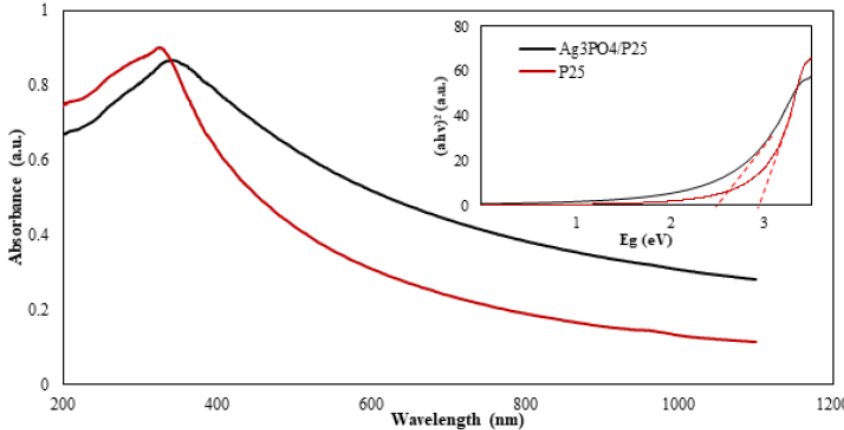
Figure 5. UV–visible spectra of P25 and Ag 3 PO 4 / P25 nanocomposite. Inset graph: Band gap determination using Tauc plot: data fitting to Equation (1).